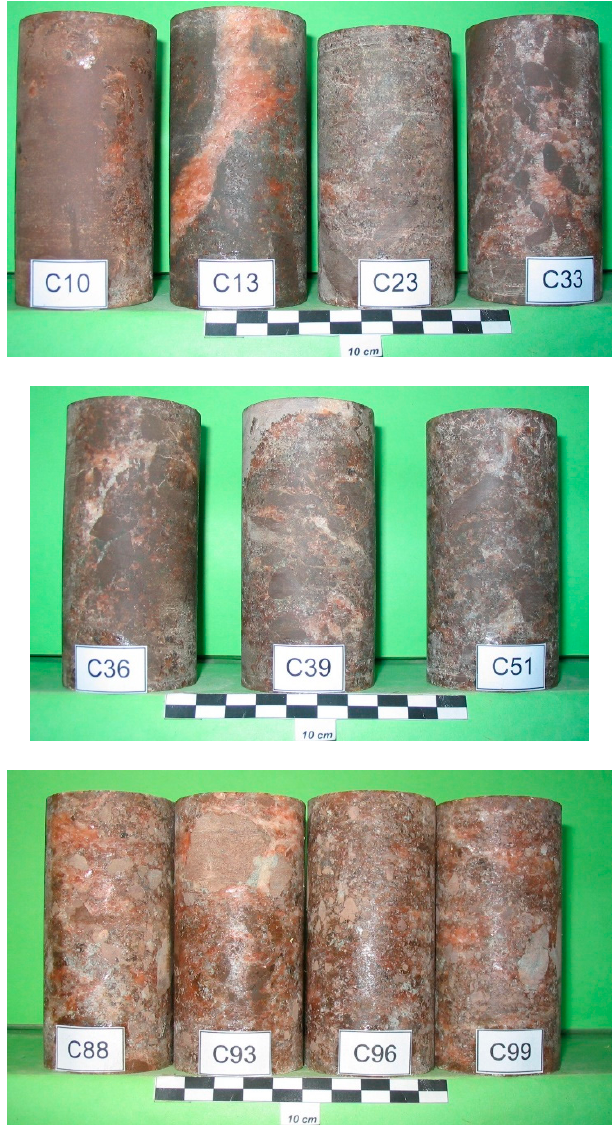
Figure A4. The Red Zuber unit samples for short-term compression tests at a constant strain rate.